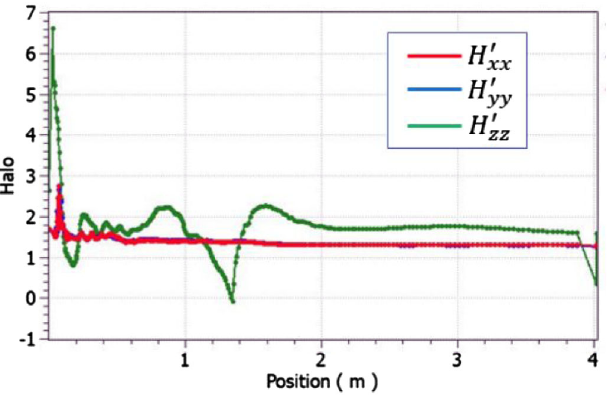
FIG. 9. Variation of transverse and longitudinal beam halo parameter along with the RFQ for the designed beam current of 10